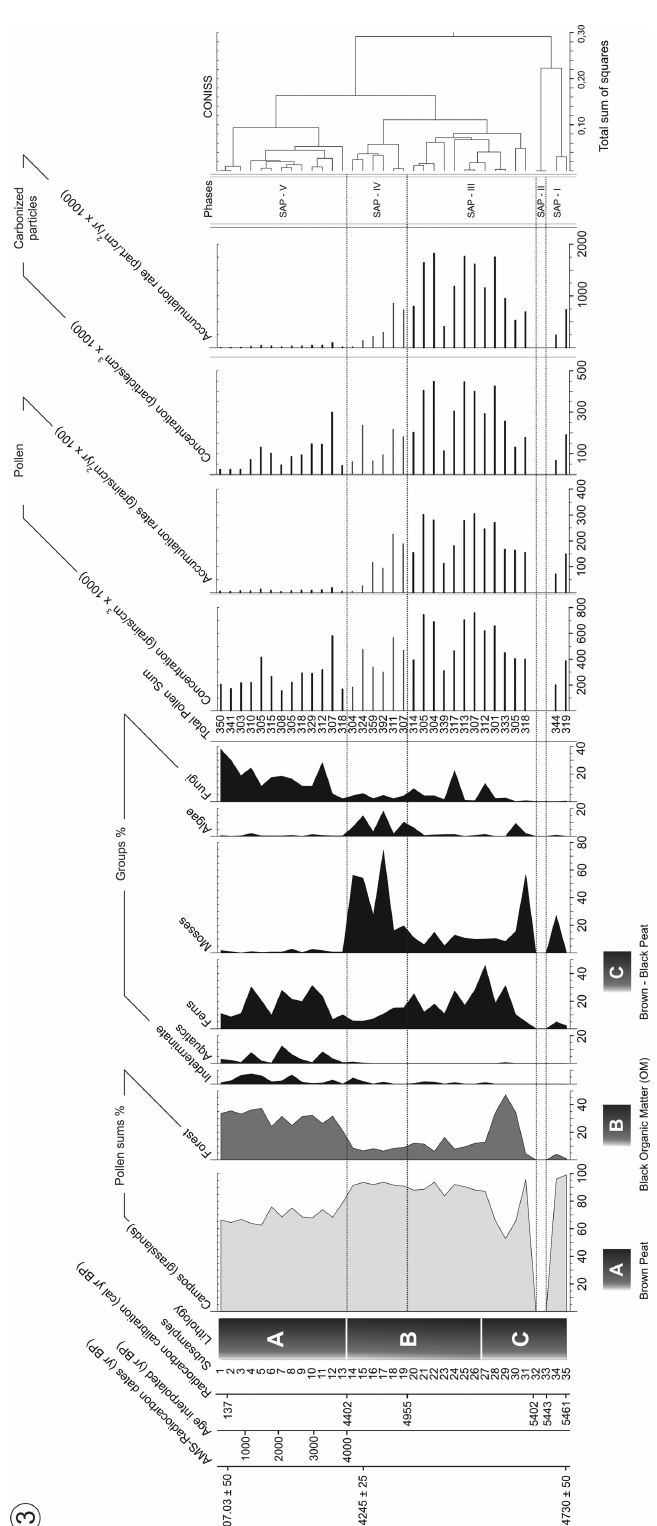
Fig. 3 – Pollen diagram summary showing the AMS radiocarbon dates, calibrated ages, interpolated ages, lithology, ecological groups, sum of pollen, pollen and charcoal concentration and accumulation records, pollen phases and the cluster analysis